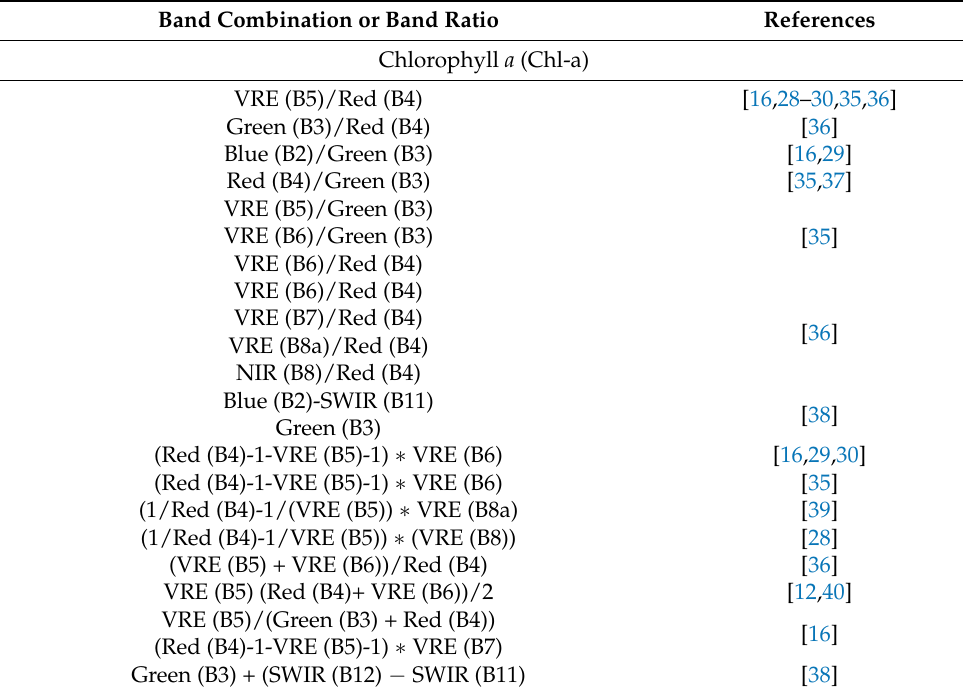
Table 1. Bands, band combinations, and band ratios applied to Sentinel-2 and/or Landsat imagery in previous studies for the development of water quality models. SWIR—Short wave